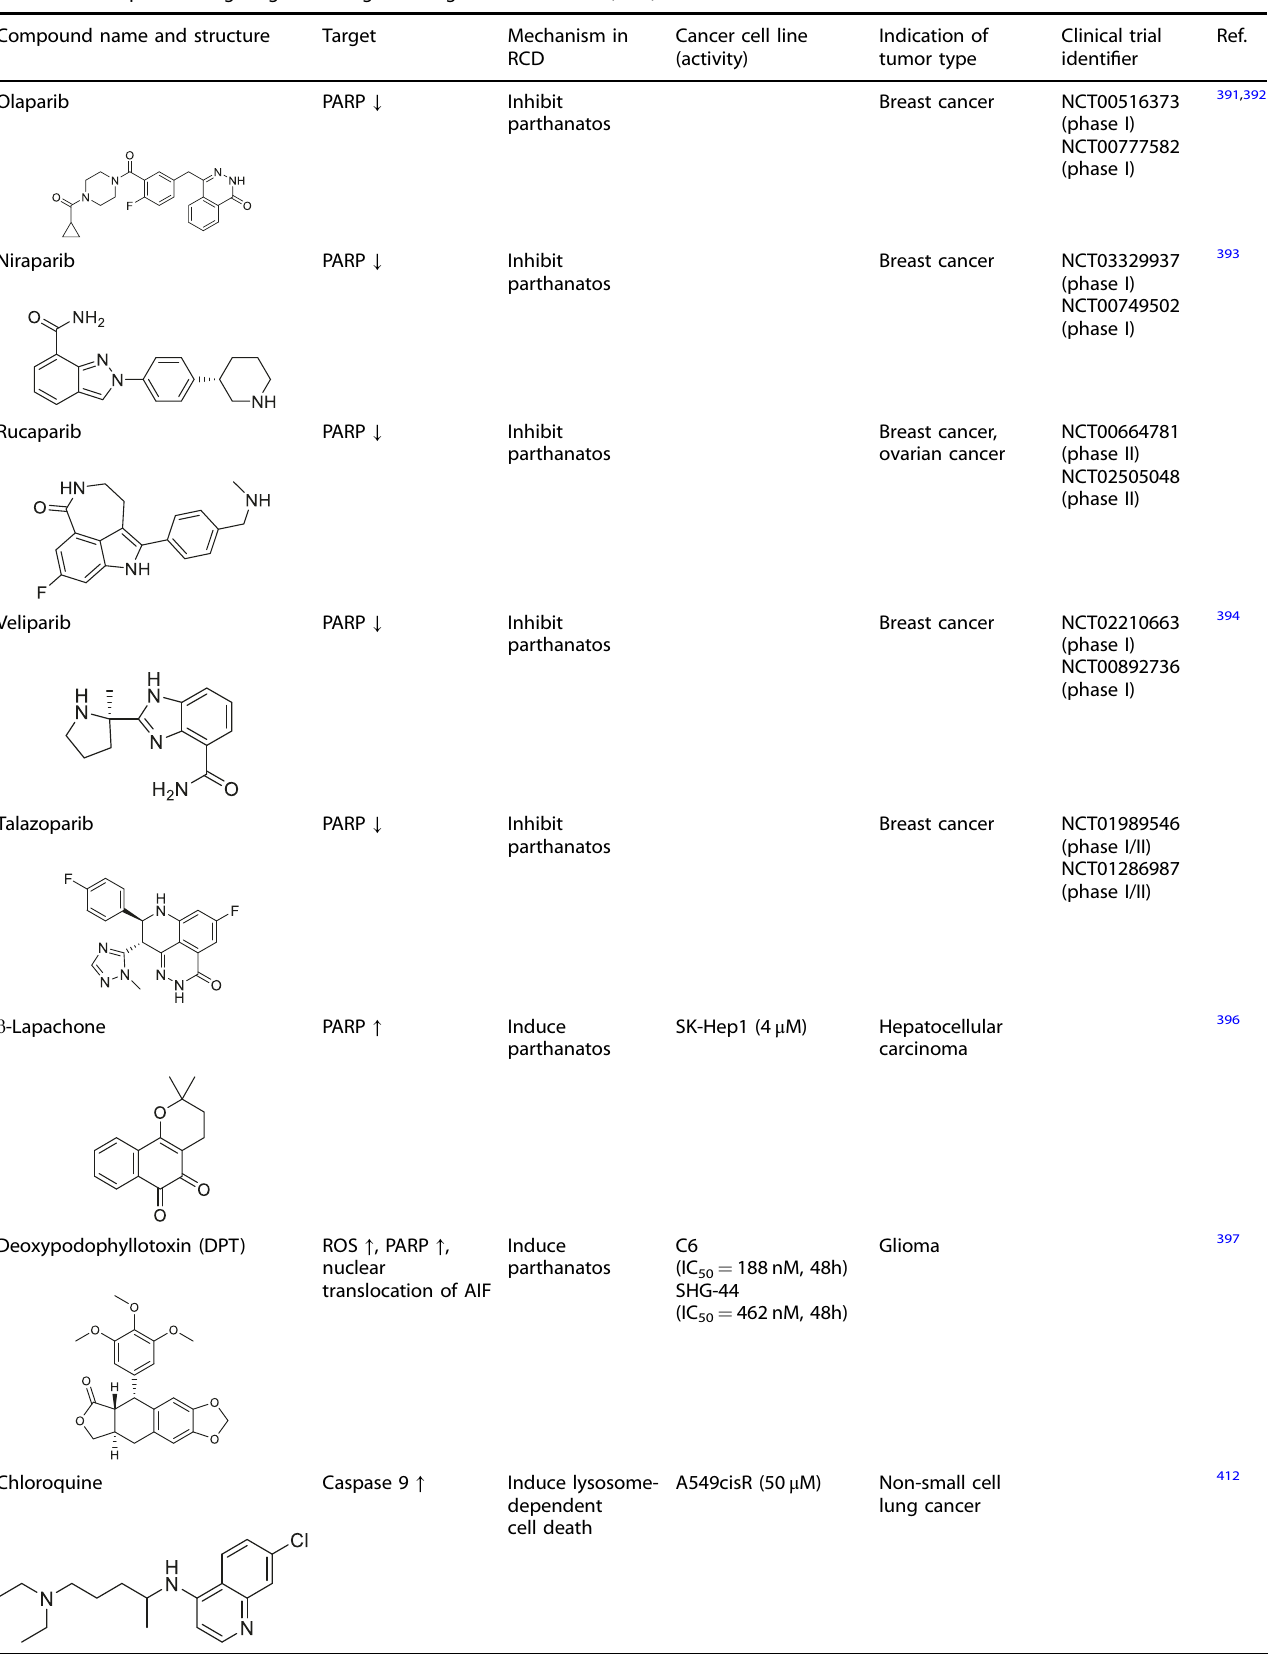
Table 13. Compounds targeting other targets of regulated cell death (RCD) in cancer Compound name and